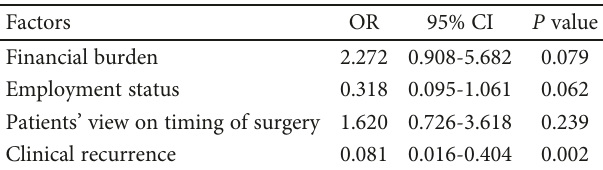
Table 3: Factors in fl uencing CD patients ’ outlook of the future after bowel